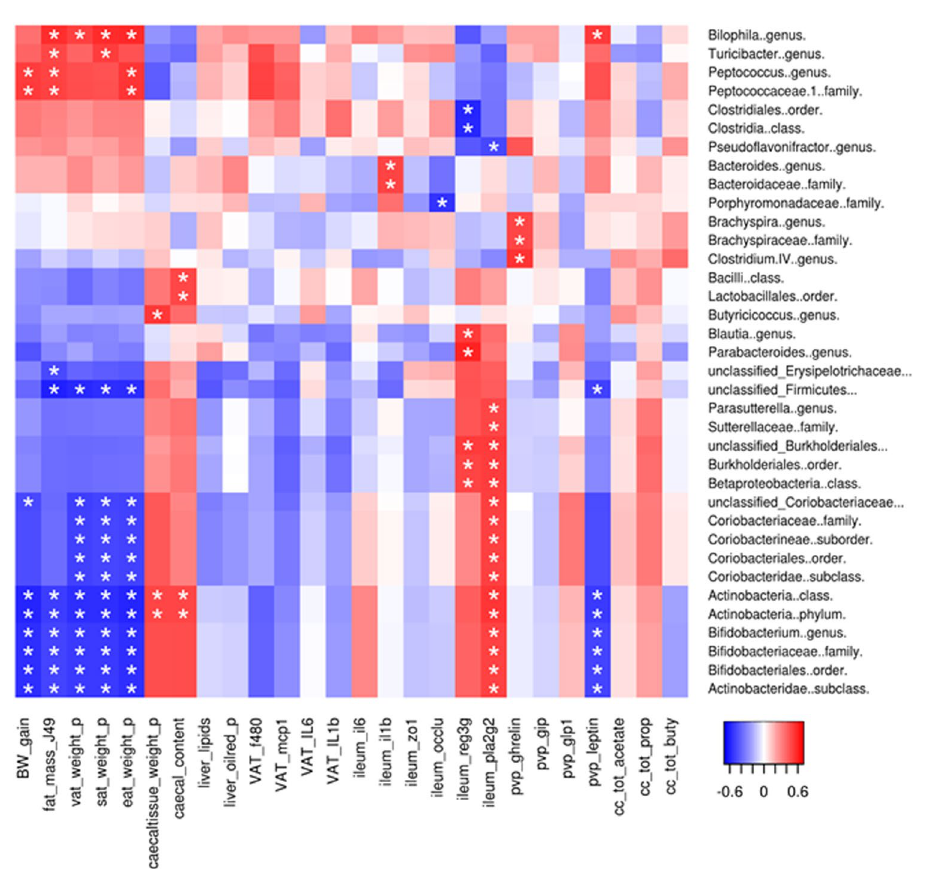
Figure 9. Correlations between bacterial taxa and host parameters. Pearson correlations were computed for all bacterial taxa with a relative abundance above 0.01% in at least one animal, and all measured host parameters. P values were adjusted for multiple testing according to the Bonferroni and Hochberg procedure. The color at each intersection refers to the value of the r coefficient; an asterisk indicates a significance correlation between these two parameters (adjusted p < 0.05). Only the bacterial taxa for which at least one significant correlation with a host parameter was detected, are displayed. Bacterial taxonomic level is indicated at the end of the